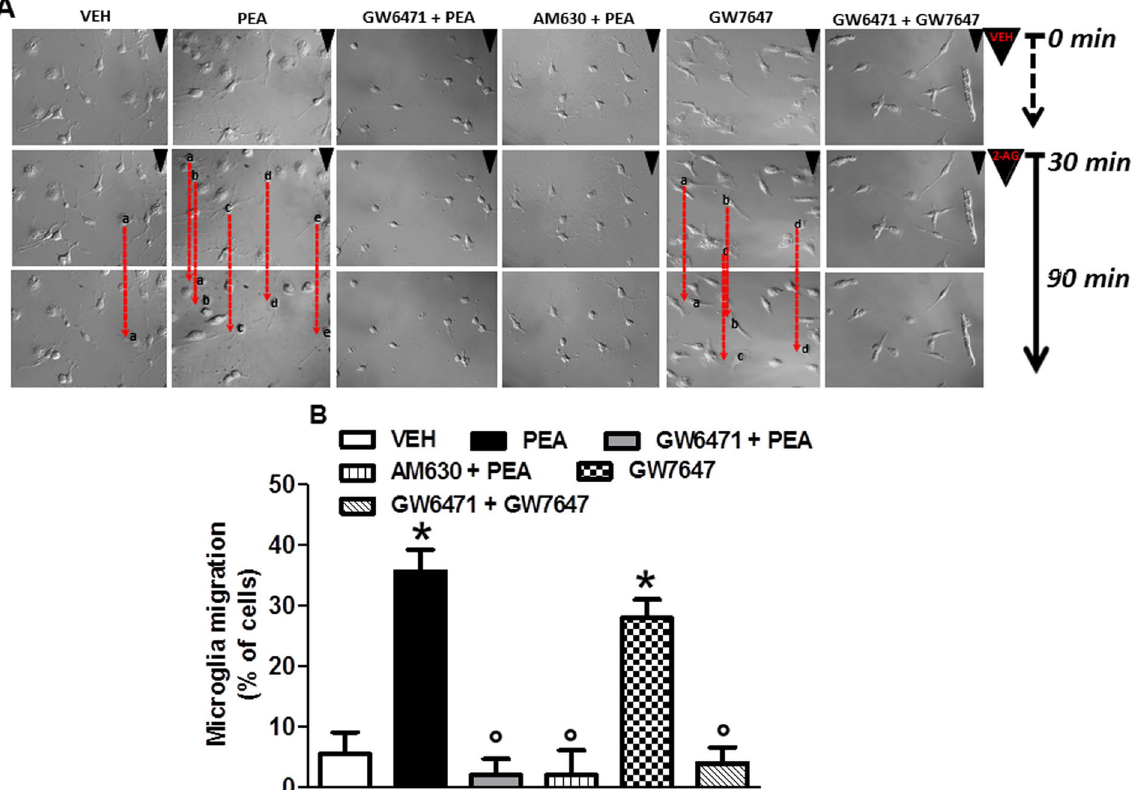
Figure 4. PEA induces microglia migration towards a 2-AG source. ( A ) Image-based detection of 2-AG (100 µ M) chemoattractive effect on cultured microglial cells after different treatments. Panel shows the migratory effect induced by PEA (100 nM) or GW7647 (1 µ M), alone or in the presence of GW6471 (10 µ M) or AM630 (100 nM), as compared to the control group (vehicle). Representative data of microglial cell time-lapse migration recorded at starting point (0 min), 30 and 90 min from the 2-AG exposure. ( B ) The quantification indicates the percentage of microglia cells affected by 2-AG chemoattractive movements vs total cell number at 90 min. Data are shown as means ± SEM (n = 6–8). * P < 0.05 compared to vehicle and °P < 0.05 compared to PEA or GW7647. One way ANOVA, post-hoc Tukey’s. Scale bar = 50 µ